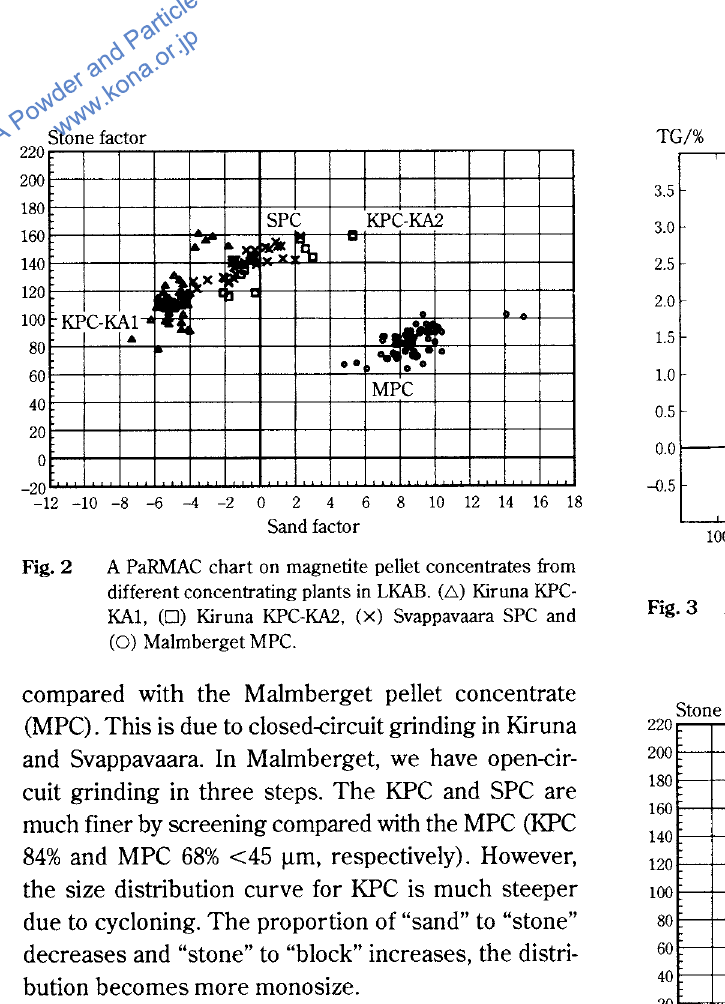
Stone factor 220